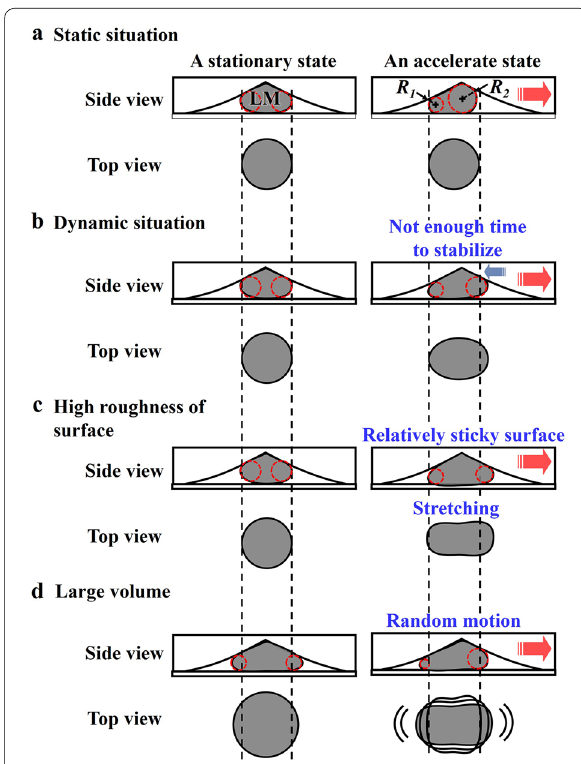
Fig. 4 a Behavior of the LM in a static situation. Analysis of the spring constant decrement in b a dynamic situation and c with a high surface roughness of the channel and dielectric layer. d Effect of large volume on the behavior of the LM with acceleration